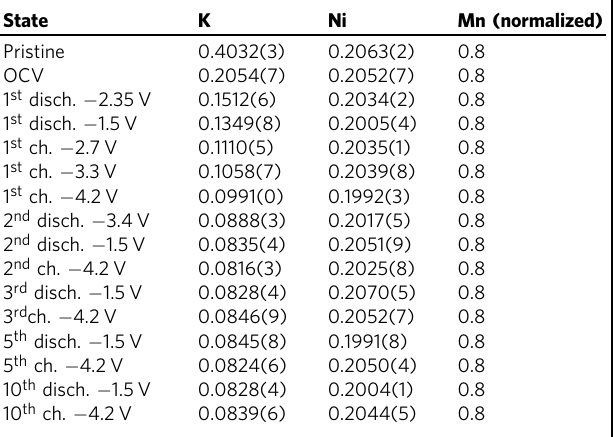
Table 1 ICP results of cathode material at indicated